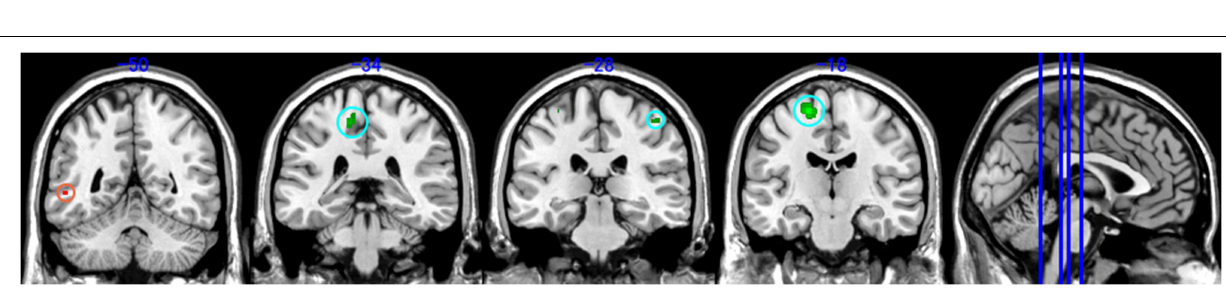
FIGURE 2 | Brain areas with significant volume reduction of white matter (WM). Green map: Control vs. PoTS, Red map: PoTS vs. Control. From left panel ( − 50): left middle temporal gyrus, ( − 34): left paracentral lobule, ( − 28): right postcentral gyrus, ( − 18): left precentral gyrus.